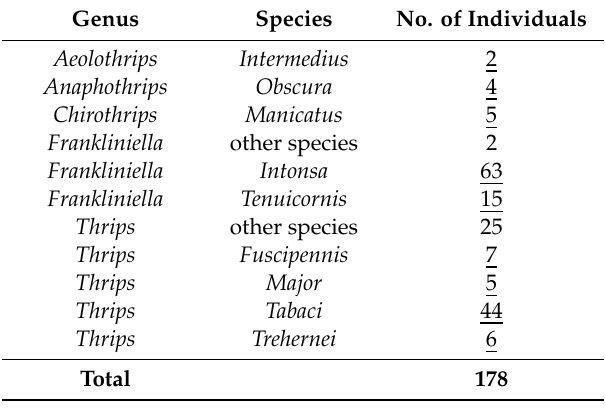
Table 2. List of the identified thrips species. Only the samples identified as species (number underlined), for a total of 151 samples, were used in the subsequent